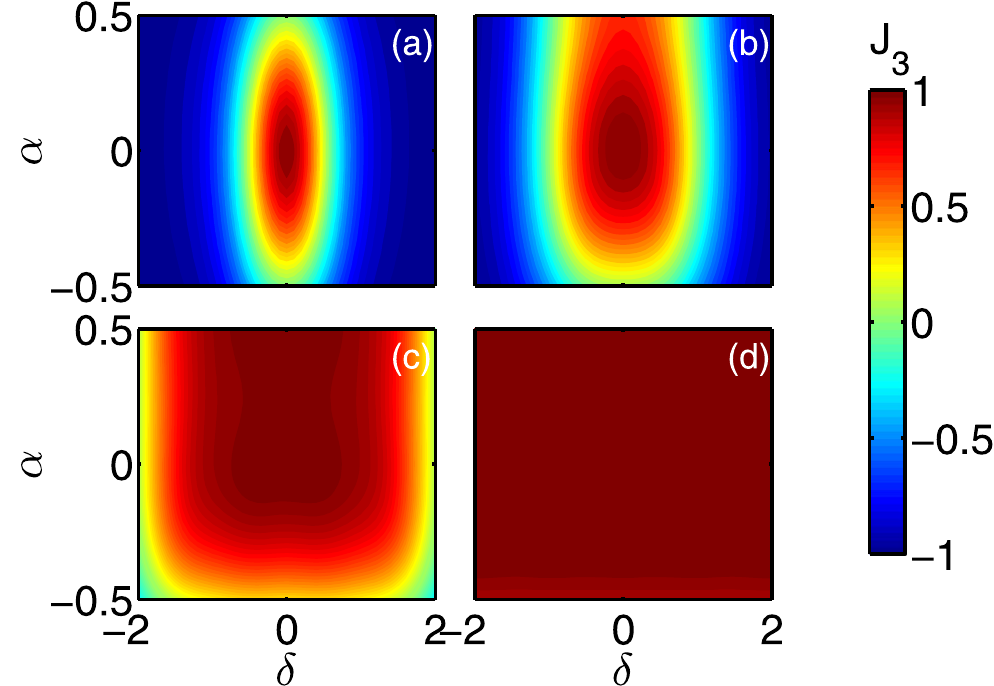
Figure 3. Efficiency and robustness of the Tennis Racket Effect pulses. The figure of merit J 3 is plotted as a function of the α and δ parameters. In the panels ( a–d ), k is respectively fixed to 0.2, 0.6, 0.9 and 0.99. The parameter  is set to 0.01 (see Supplementary Sec. II for